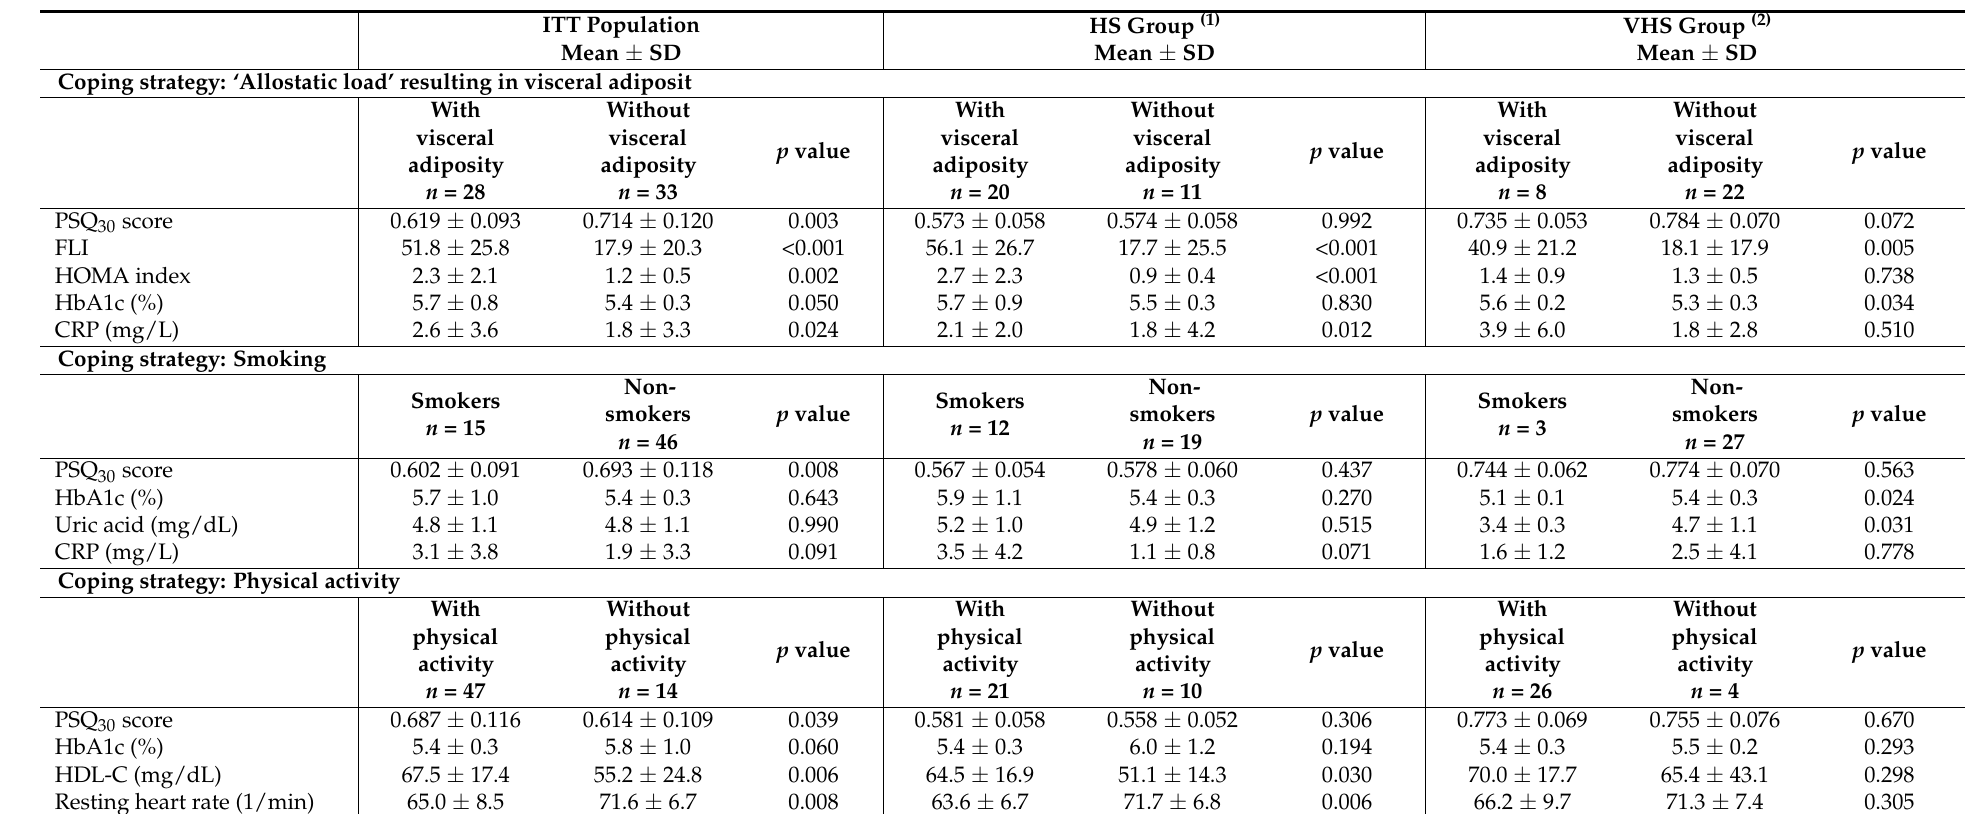
Table 4. Coping strategies and cardiometabolic health of